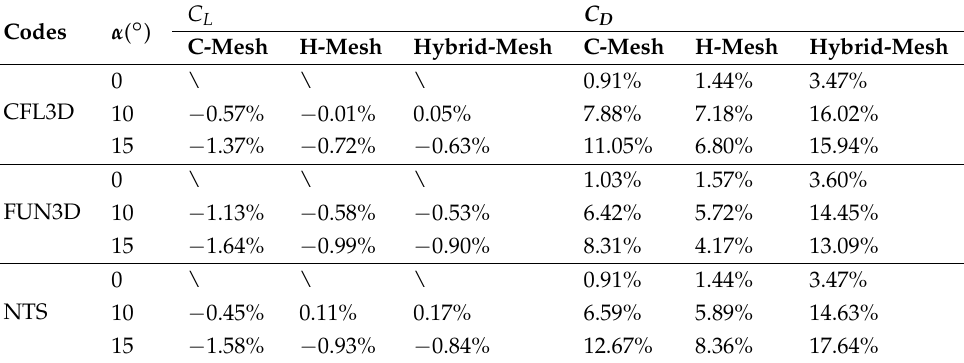
Table 28. Comparison of mesh types with recommended settings to that of other CFD codes adopted from [19] in relative differences.